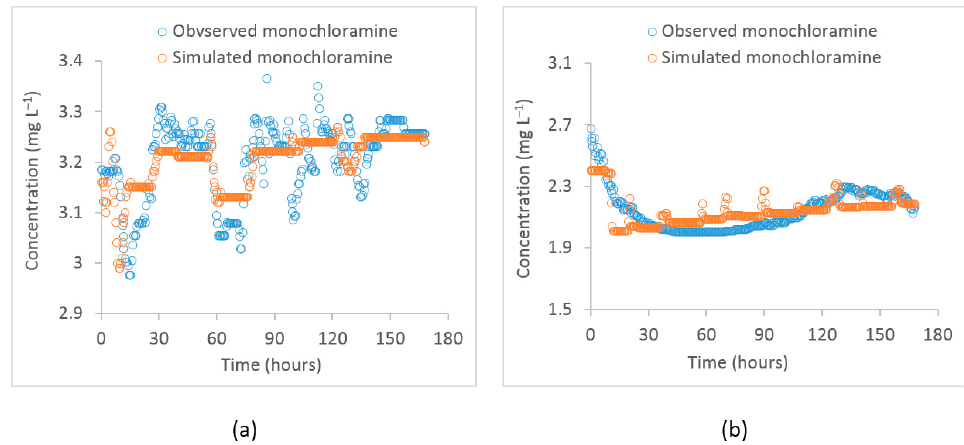
Figure 6. Time ‒ series plot of observed vs. simulated monochloramine concentrations by the Figure 6. Time–series plot of observed vs. simulated monochloramine concentrations by the EPANET EPANET model during the validation period at ( a ) the PS2 inlet and ( b ) Meningie. model during the validation period at ( a ) the PS2 inlet and ( b ) Meningie.